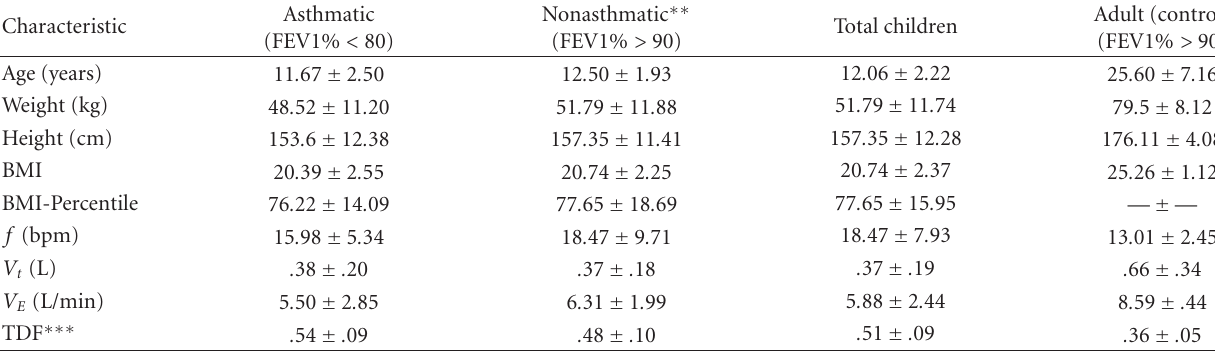
Table 2: Subject demographics and summarized results ∗ .